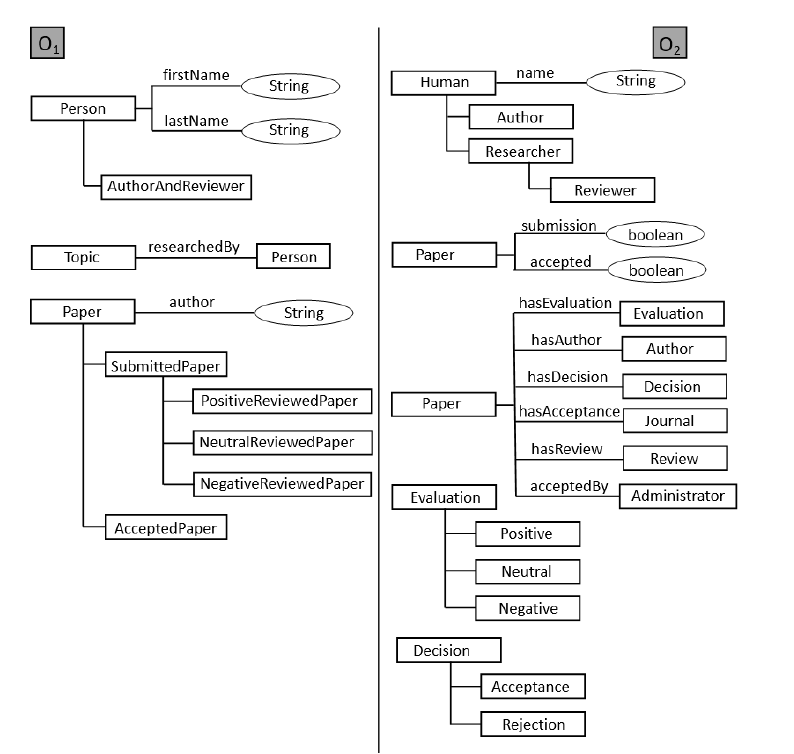
Figure 2. A segment of testing case from OAEI conference